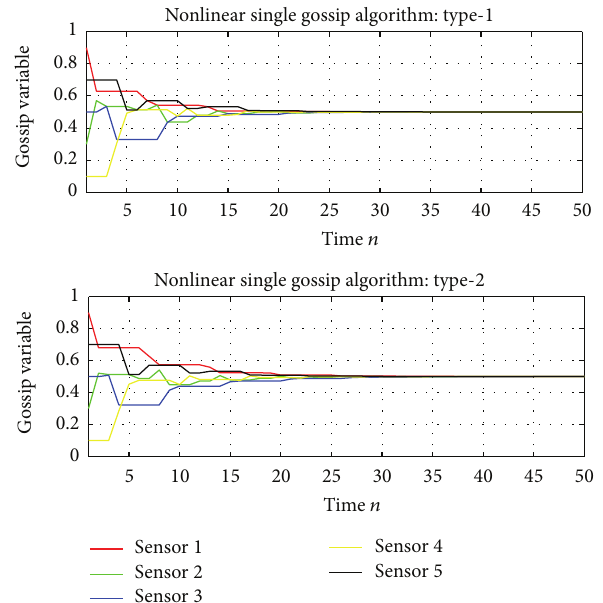
Figure 2: Simulations of the single gossip algorithm for type-1 and type-2.